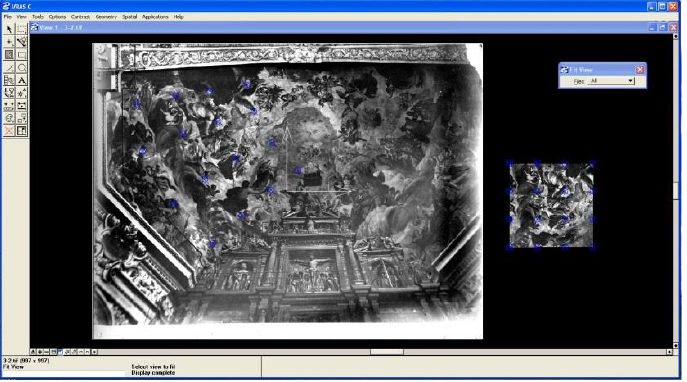
Figure 9. The 4 × 4 mesh projected on the model. Expanded mesh detail.